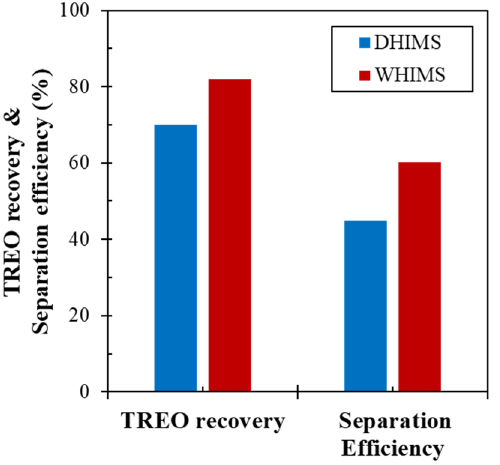
Figure 7. Comparison of TREO recovery and separation efficiency by DHIMS and WHIMS.